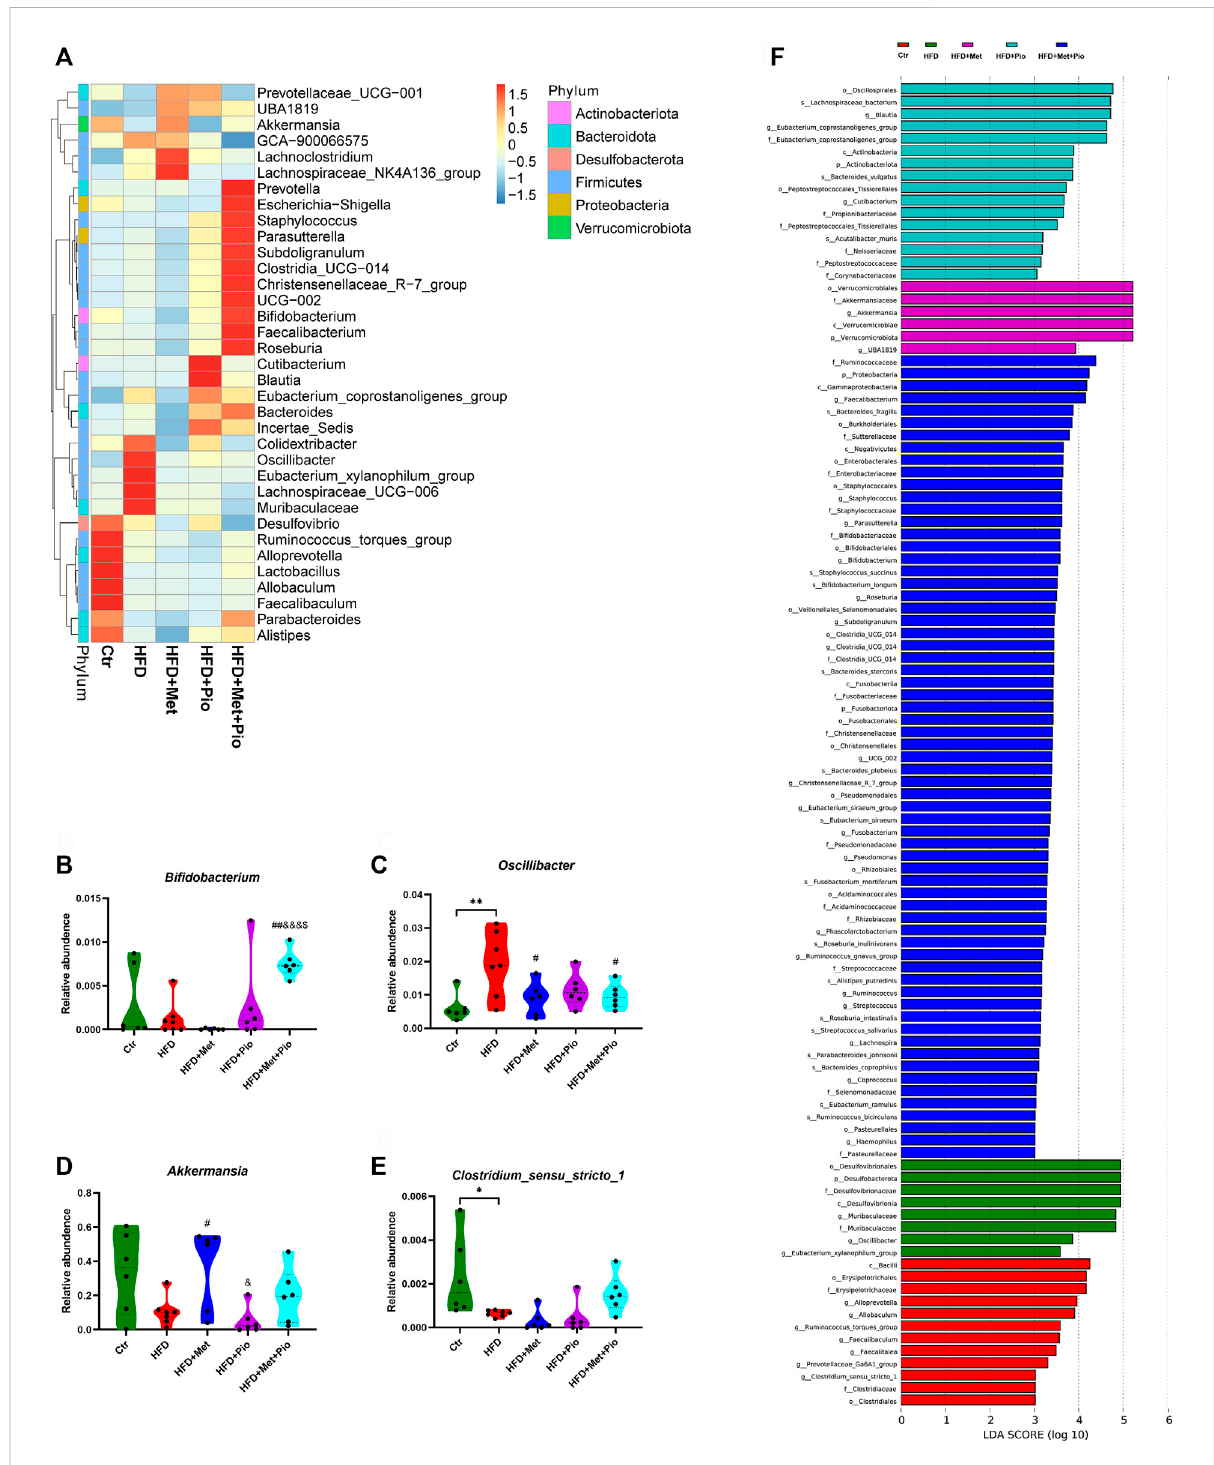
FIGURE 3 Changes in gut microbiota with combination therapy of metformin and pioglitazone. (A) Heatmap analysis of the different species at the genus level; (B) Relative abundance of Bi fi dobacterium ; (C) Relative abundance of Oscillibacter ; (D) Relative abundance of Akkermansia ; (E) Relative abundance of Clostridium_sensu_stricto_1 ; (F) LEfSe analysis of the signi fi cantly enriched gut microbiome from the phylum level to the genus level. Ctr,standardcontrol diet;HFD, high-fat diet;HFD+Met,high-fatdiettreatedwith metformin; HFD+Pio, high-fat diettreated withpioglitazone; HFD+Met+Pio, high-fat diet treated with metformin and pioglitazone. Data are expressed as the means±SDs. ( n = 6 – 7/group). One-way ANOVA; * p < 0.05, ** p < 0.01, *** p < 0.001 HFD versus Ctr group; # p < 0.05, ## p < 0.01, ### p < 0.001 HFD+Met group versus HFD group, HFD+Pio group versus HFD group, or HFD+Met+Pio group versus HFD group; & p < 0.05, and& p < 0.01, andand& p < 0.001 HFD+Pio group versus HFD+Met group, or HFD+Met+Pio group versus HFD+Met group; $ p < 0.05, $$ p < 0.01, $$$ p < 0.001 HFD+Met+Pio group versus HFD+Pio